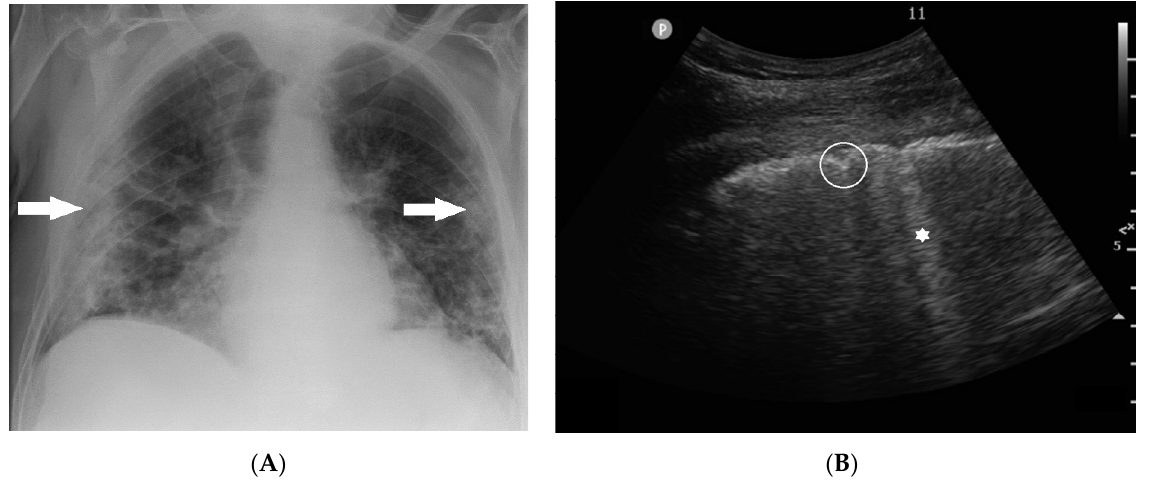
Figure 4. ( A ) Chest X-ray and ( B ) lung ultrasound of an 81-year-old patient with consolidations at the periphery of both lungs (arrow) in CXR and corresponding loss of aeration with well-defined B-lines (asterisk) and pleural line irregularities (circle) in LUS at presentation in hospital. LUS was performed with a convex C6-2 probe with a 2–6 MHz frequency range.